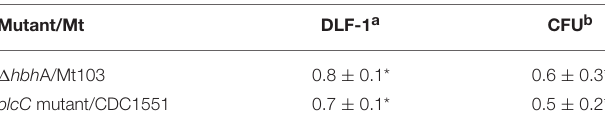
TABLE 1 | Bacterial cell infection ratios of mutants to the parental wild type strains calculated using DLF-1 labeling fluorescence and CFU,